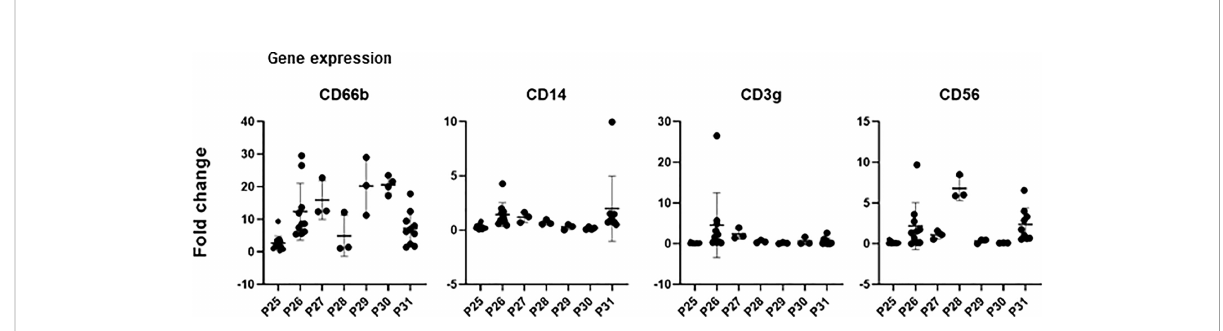
FIGURE 6 Gene expression analysis. Dry pellets from urine cells were processed for RNA extraction, followed by reverse transcription and cDNA were analysed by qPCR. Primers for the indicated genes were used and number of ampli fi cation cycles was measured. Plots represent the fold change relative to the reporter gene b-actin of a control population of granulocytes or PBMC (2 - DD Ct